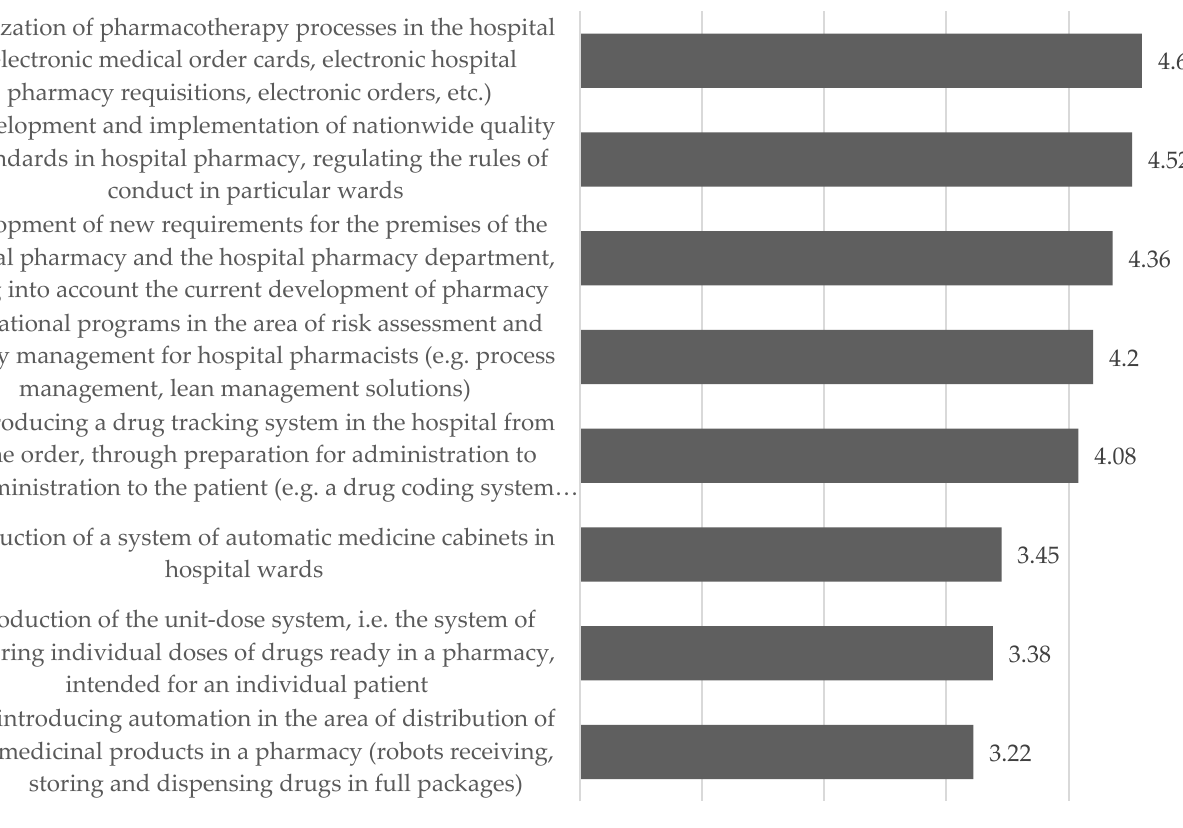
Figure 5. Assessment of the need to introduce changes in the distribution area—mean.